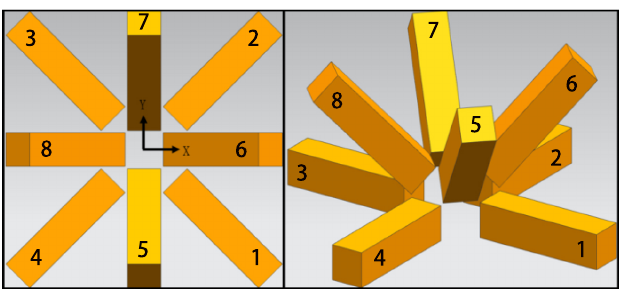
Figure 5. Rectangular electromagnetic coil set actuation platform